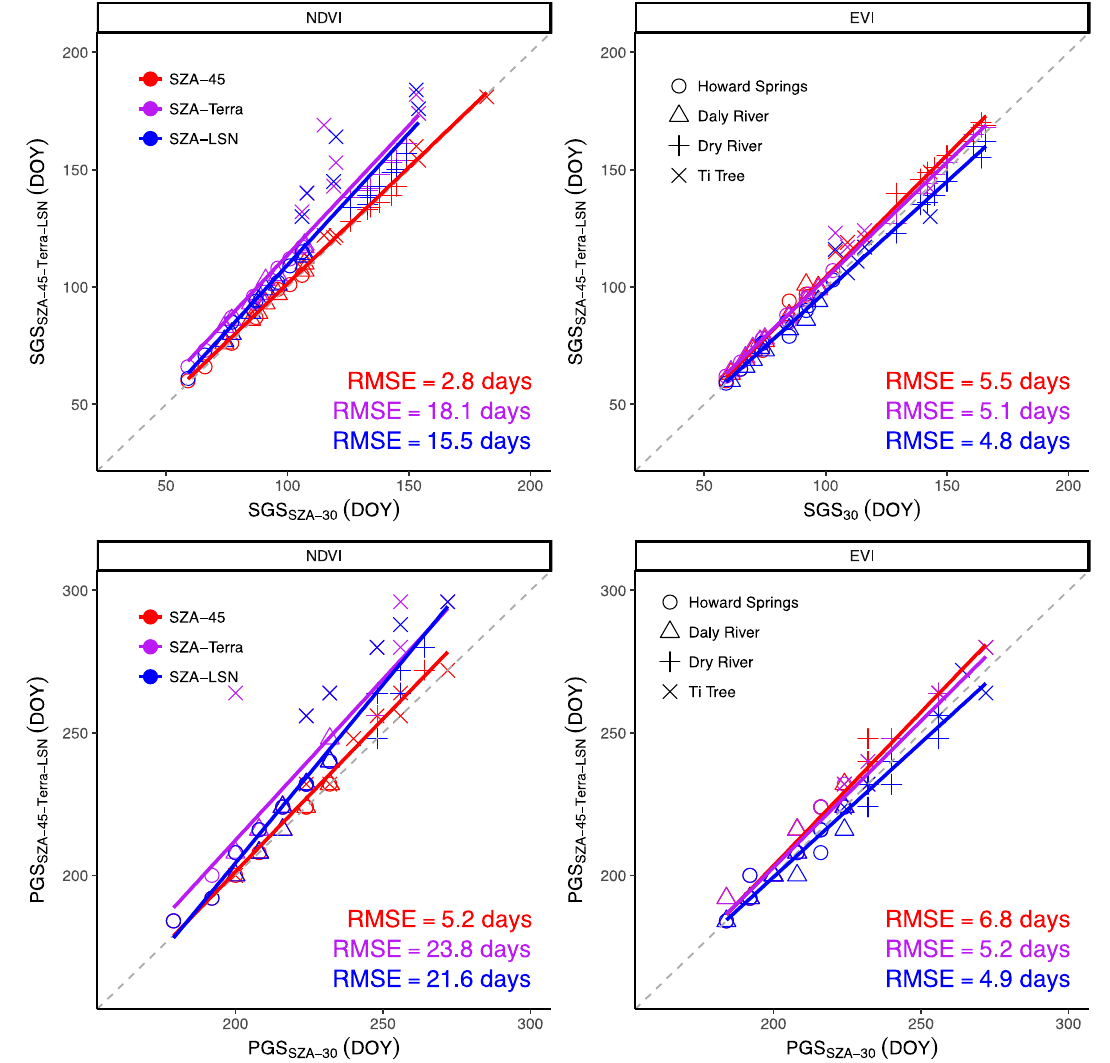
Figure 10. Cross-site relationship between the phenological metrics extracted from NDVI and EVI with different SZA configurations across four NATT sites. SGS—start of greening season; and PGS—peak of greening season. Phenological metrics extracted from the NDVI and EVI with three different SZA configurations (all at nadir view), with SZA varying according to the Terra overpass time (SZA-Terra) and the local solar noon (SZA-LSN), or fixed at 30° (SZA-30) or 45° (SZA-45).